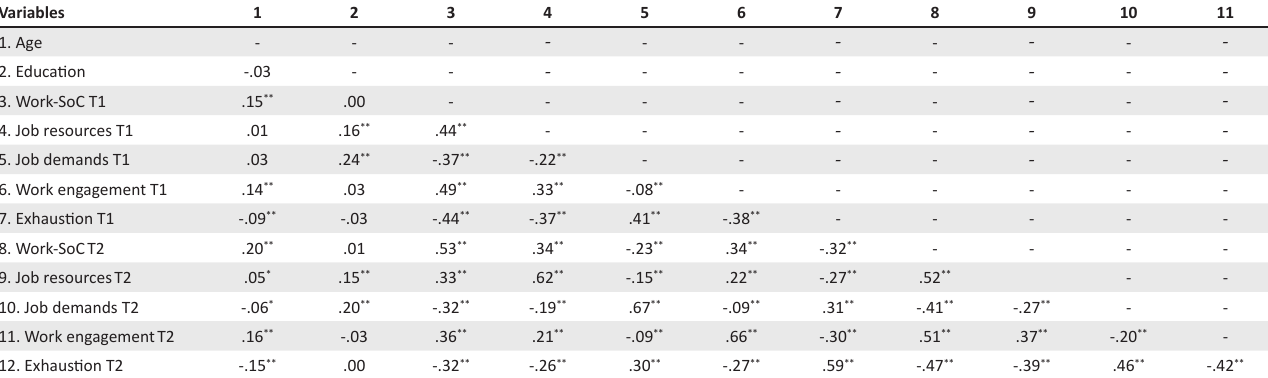
TABLE 2: Inter-correlations of the studied variables ( N = 1233 to 3639).